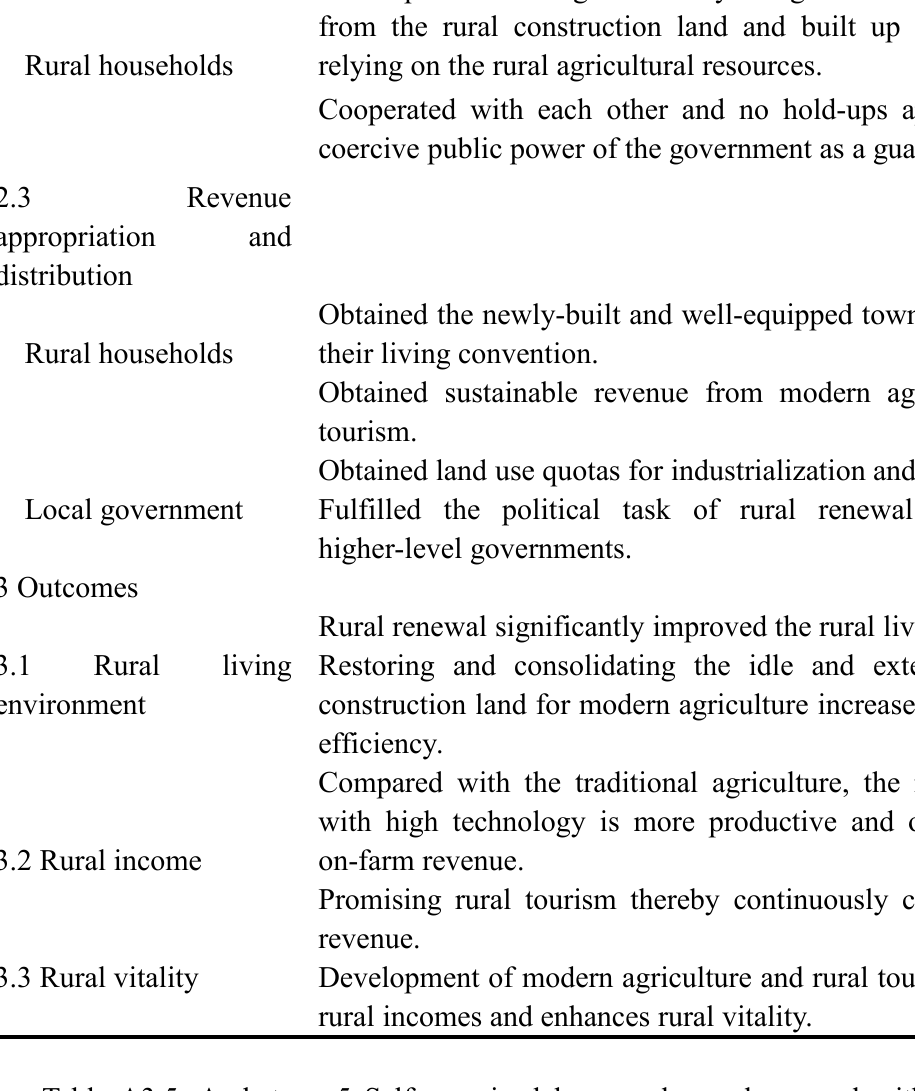
Table A3.5: Archetype 5 Self-organized large-scale rural renewal with a long-term